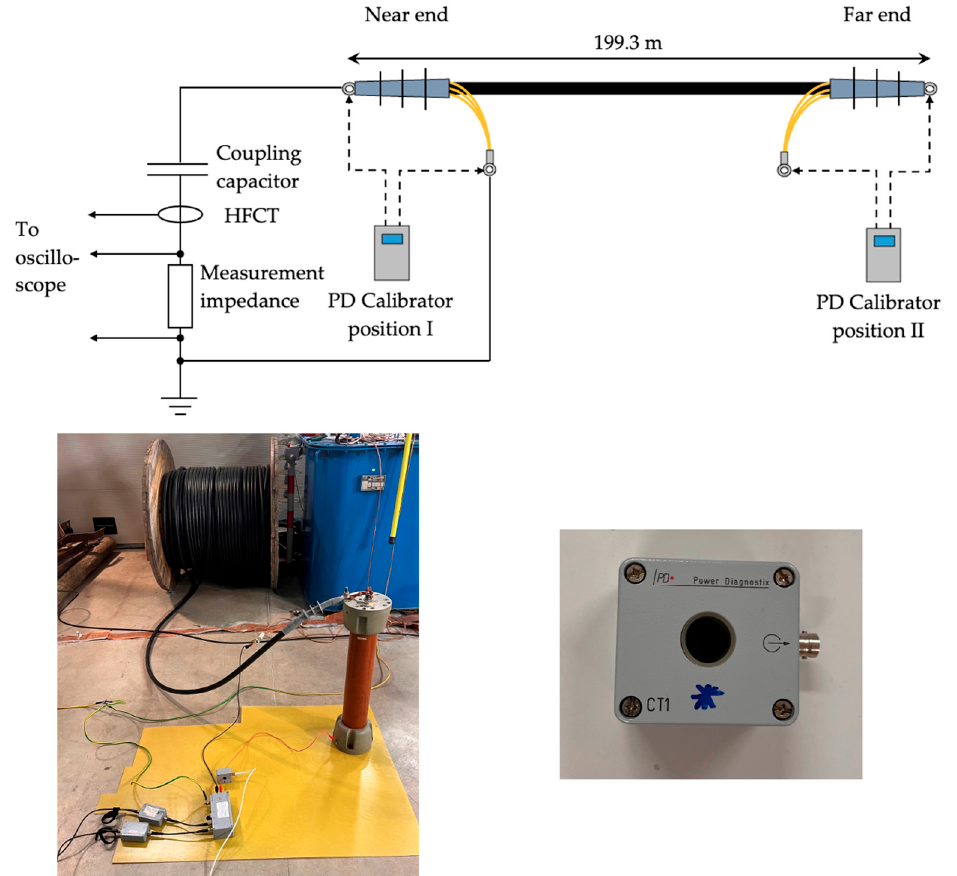
Figure 2. Test setup for measuring pulse propagation velocity in a power cable ( top ); test setup in the laboratory ( bottom left ); high-frequency current transformer used in experiments ( bottom right ).